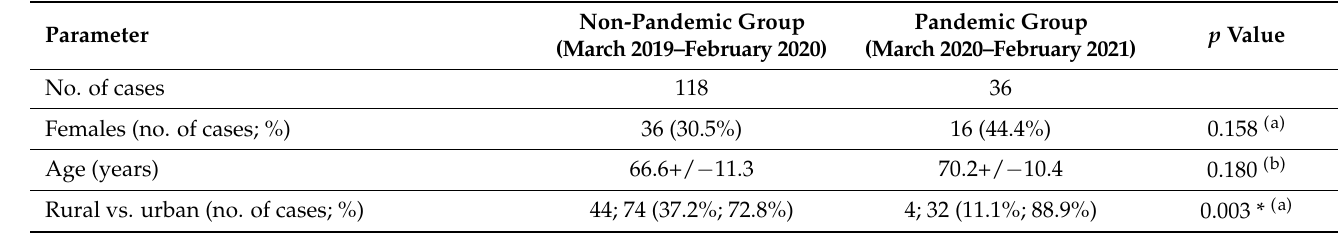
Table 1. General data of the patients that underwent surgery for colorectal cancer in the 2 study groups (the percentages are calculated based on the total of the corresponding column, namely 118 and 36,